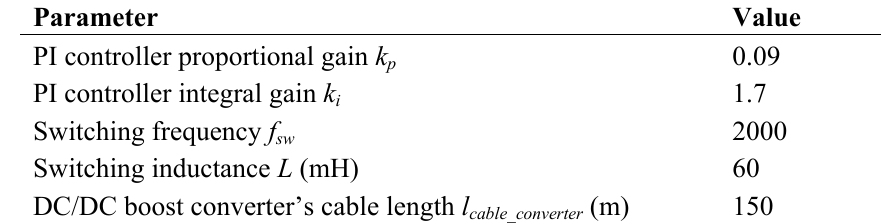
Table 3. Main parameters for each DC/DC boost converter and for the DC